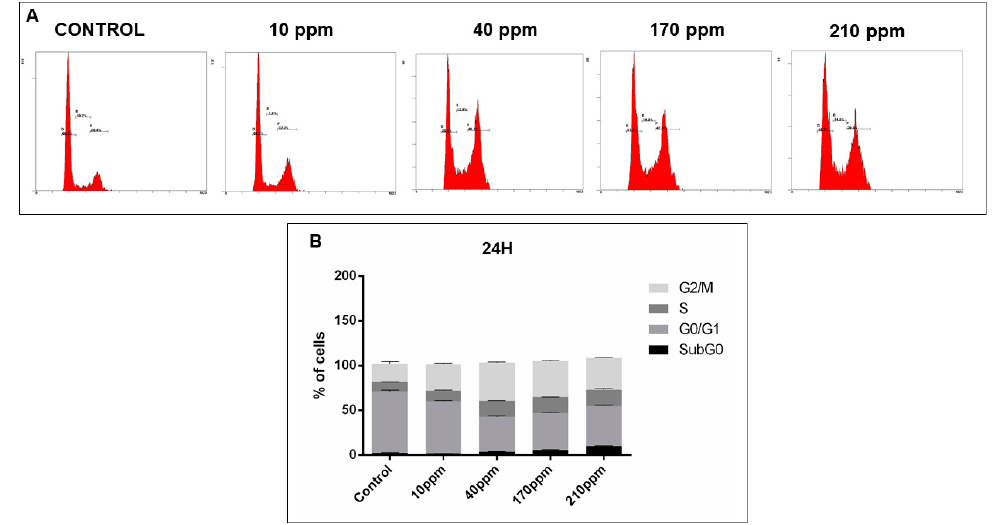
Figure 12. Cell cycle analysis, of PC-3 cells treated with different concentrations of AgNPs for 24 h, assessed using a PI stain and flow cytometry. ( A )—Representative DNA histograms. ( B )—Quantitative analysis of PC-3 cells AgNPs treated. Data is expressed as mean ± SEM.